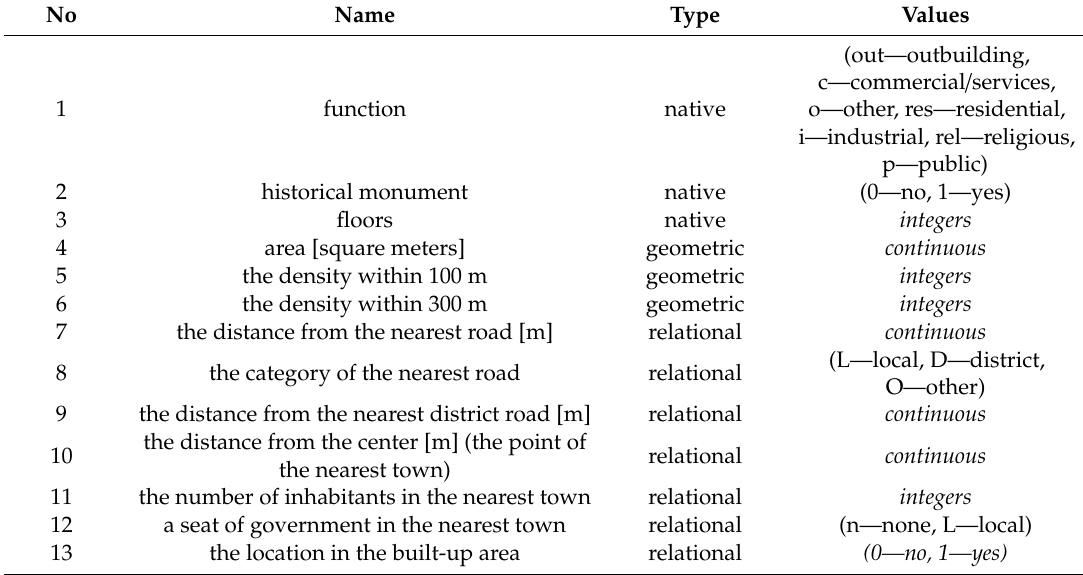
Table 1. The attributes of the buildings in model data with the indication of the types of attributes and their values; source: own work.